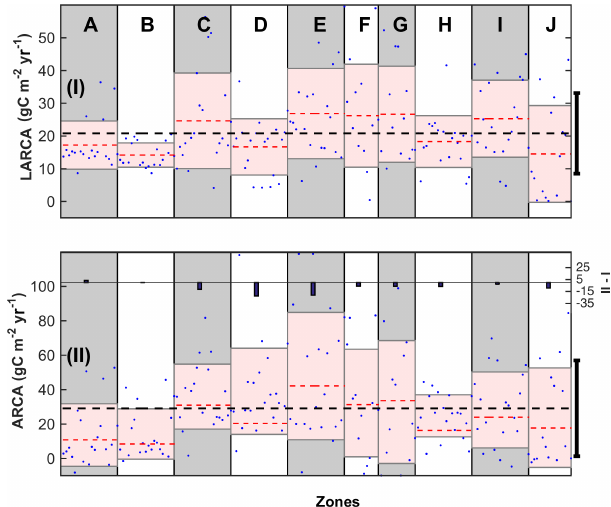
Figure 7. Simulated C accumulation rate (blue lines) for each zone (refer to Figs. 1 and 4) and across the pan-Arctic region. The black dashed line is the pan-Arctic average with standard deviation (black line outside); the red dashed line is the average for the respective zone with the standard deviation as a light red patch. (I) Average simulated near future rate of C accumulation (NFRCA) for 2001– 2100 in the FTPC8.5 experiment; (II) simulated NFRCA in the T8.5 experiment, (III) simulated NFRCA in the P8.5 experiment and (IV) simulated NFRCA in the C8.5 experiment. Blue bars show the difference between the FLARCA and LARCA values for each